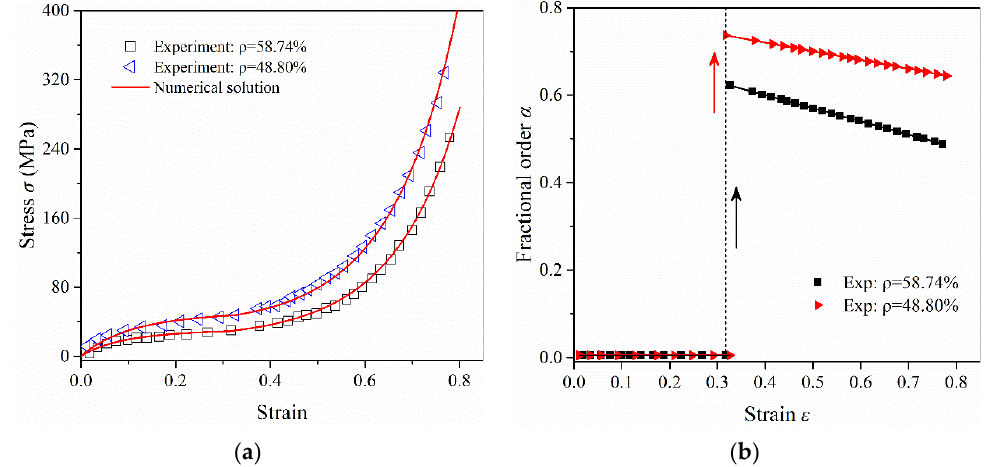
Figure 7. ( a ) Comparison of the compressive experimental data of described aluminum foams with different porosities and the prediction of our model; ( b ) Derived order variance of the proposed numerical stress response. (Experimental data were taken from [54].).